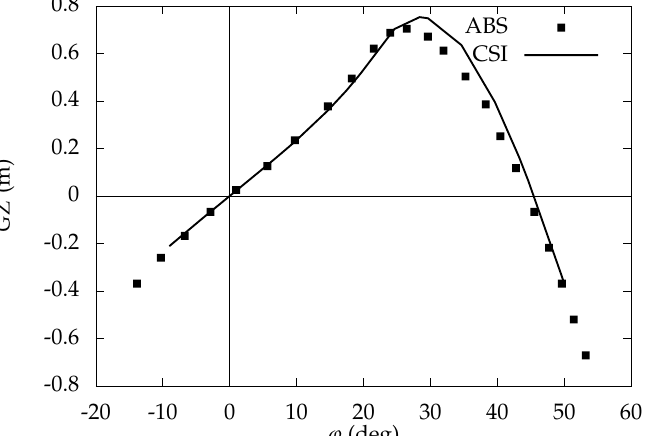
Figure 22. GZ curve for KCS container ship test case for the assessment of dead ship level 1. Table 26. Level 1 assessment of dead ship failure mode for KCS container ship.